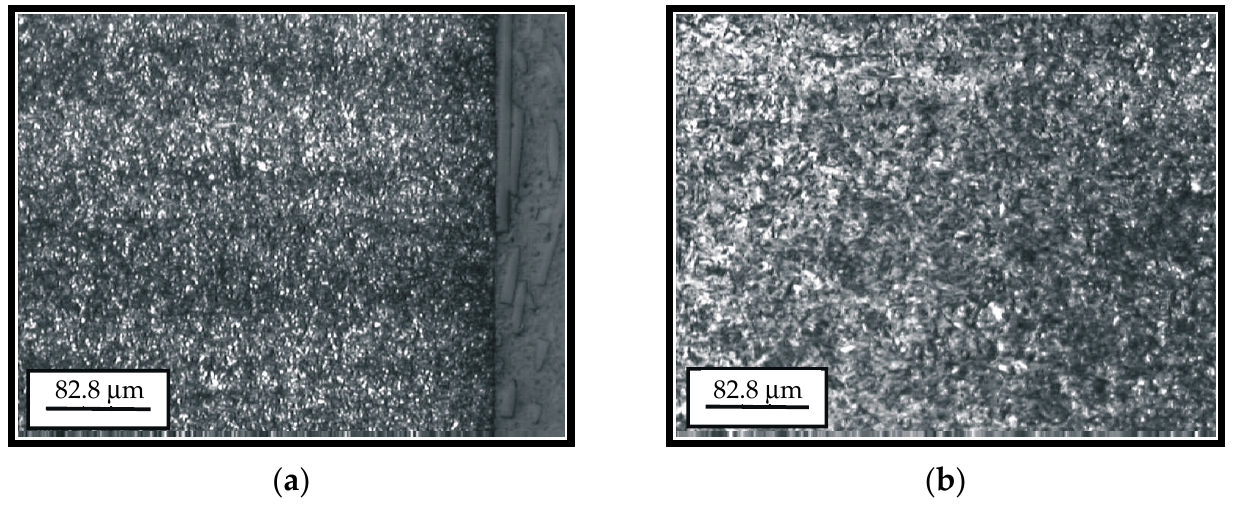
Figure 1. Microstructure of the cemented layer ( a ) and the transient zone ( b ). The microstructure of the surface and subsurface layers (cemented layer and the core of the newly manufactured tooth) is presented in Figure 1a. The basic micro-constituent of the tooth cemented layer is the tempered martensite (dark areas in the figure). The smaller share of the retained austenite can also be noticed. In the surface zone, up to the depth of 0.2 to 0.3 mm, individual coarser carbides of the alloying elements are also present. Based on the appearance of the martensite needles, one can conclude that the material possesses a fine-grained structure, which points to the fact that the heat treatment process was properly conducted. Based on Figure 1b, one can see the difference between the microstructures of the cemented layer (the right-hand portion of the figure), microstructure of the transient zone (the middle portion of the figure) and microstructure of the core (the left-hand portion of the figure). Individual ferrite grains can be noticed in the transient zone (the coarser brighter areas), the number of which is much bigger in the